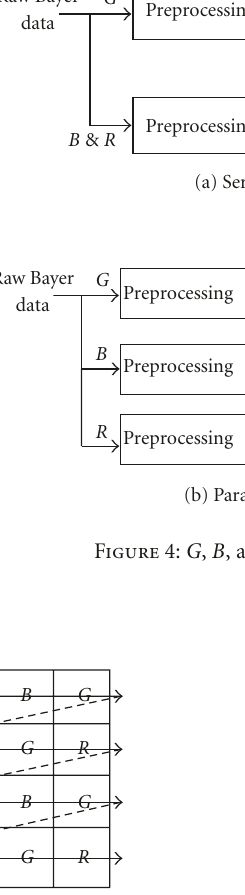
Figure 5: Progressive scan sequence of a CMOS image sensor.